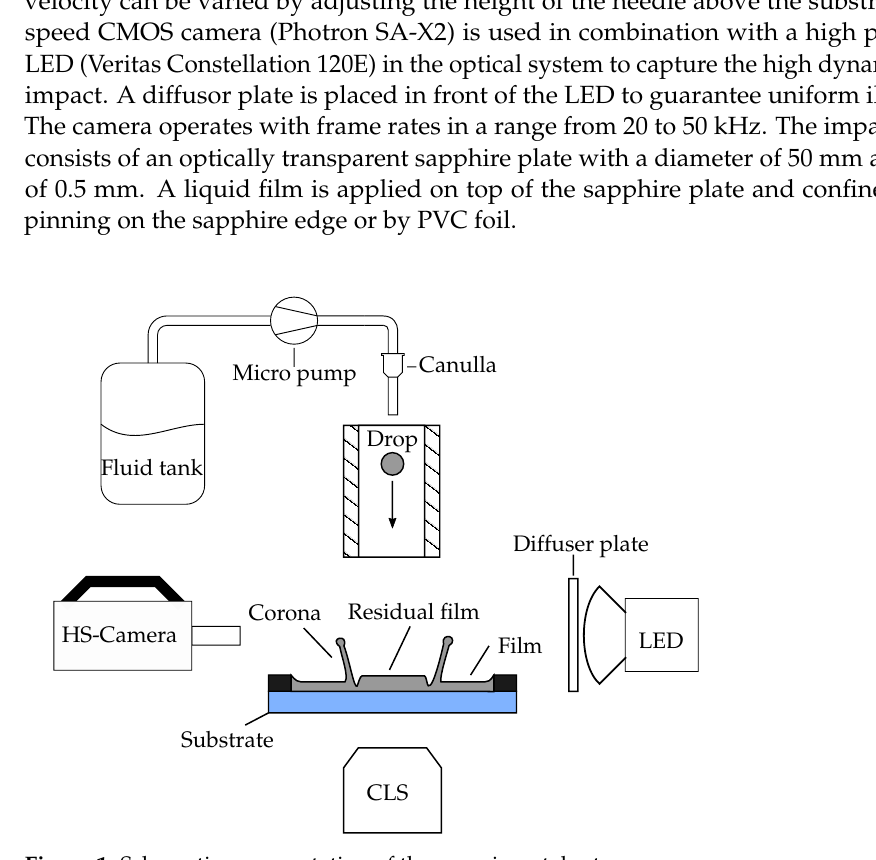
Figure 1. Schematic representation of the experimental setup. The height of the film on the substrate is determined using a chromatic-confocal line sensor (Precitec Chrocodile, short: CLS) in combination with a CLS 0.5 LL probe. This system can determine the film thickness on a line of 4.5 mm length with a rate of 2 kHz at high accuracy of ± 0.5 µ m. It allows for precise measurement of the film thickness before the drop impact while also providing spatial and time-resolved film thickness information during and after drop impact. The CLS and the high-speed camera are synchronized by use of a NI-DAQ system in combination with an in-house LabView code. Since in this study miscible liquids with the same refractive index of n = 1.402 are investigated, no detectable interface forms between drop and film, thus the measured film thickness after impact is the total thickness of both, drop and film liquid combined. The properties of the liquids used in this study are summarized in Table